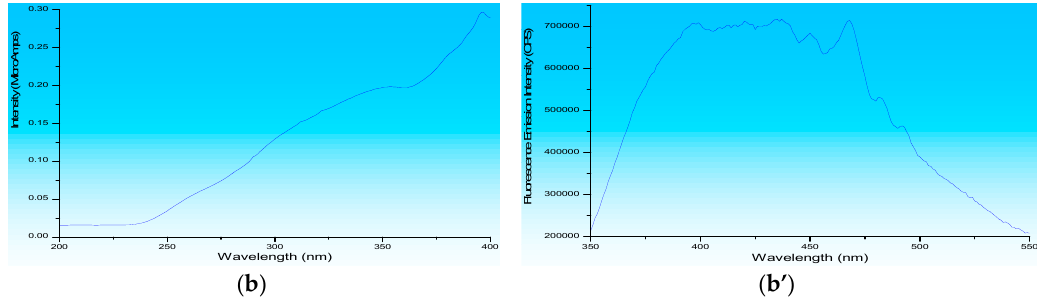
Figure 1. Fluorescence excitation spectra using λ em = 450 nm: ( a ) lecithin liposome-encapsulated TiO 2 nanoparticles, and ( b ) lecithin liposome-encapsulated TiO 2 -PDA nanoparticles. Fluorescence emission spectra using λ ex = 300 nm: ( a’ ) lecithin liposome-encapsulated TiO 2 nanoparticles; and ( b’ ) lecithin liposome-encapsulated TiO 2 -PDA nanoparticles.